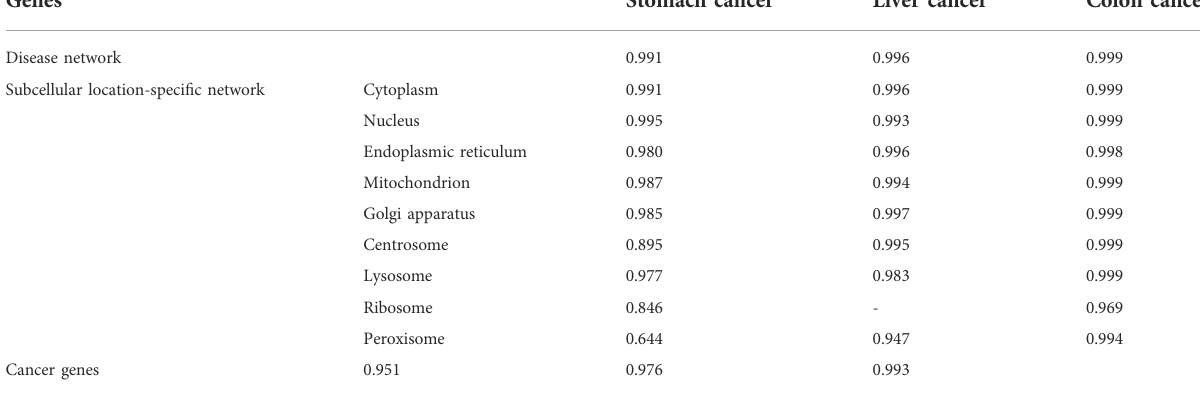
TABLE 4 Classi fi cation performance (AUC) of candidate leader genes.